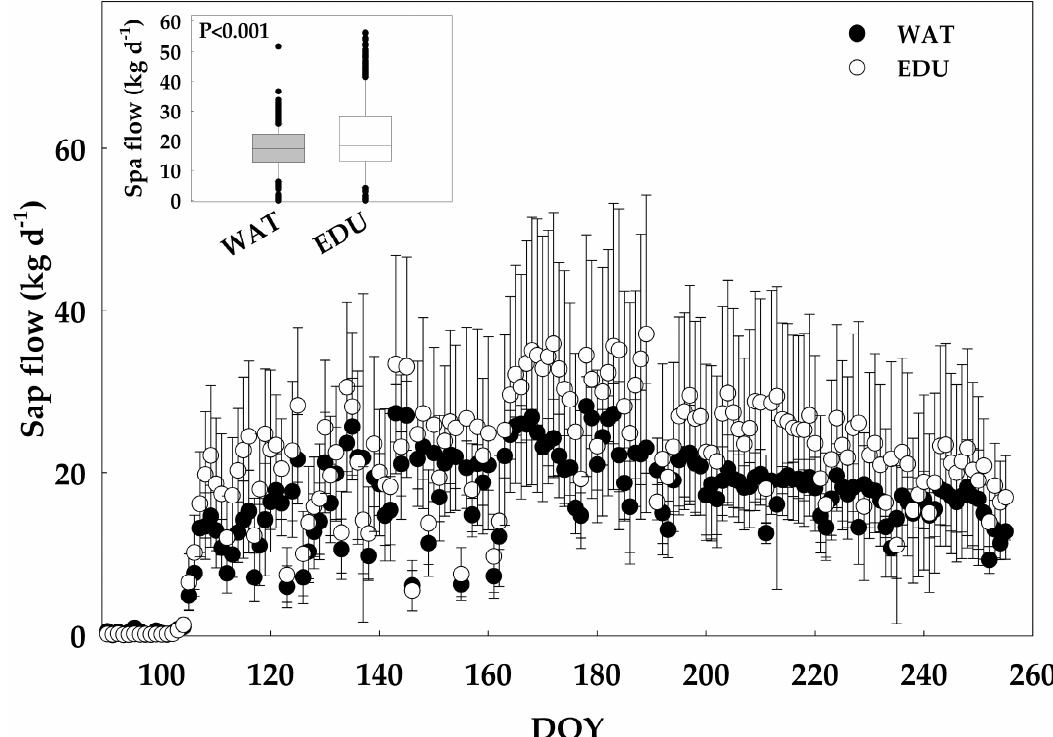
Figure 4. Time course of sap flow (±SD) during the growing season 2013 ( N = 5 trees). The inset shows the box-plot representing the range of daily sap flow in WAT (water treated) and O 3 -protected EDU (EDU treated) trees. The box shows the distribution of the 25–75% quartiles, the median is represented by a horizontal line within the box, vertical bars indicate minimum/maximum values and circles symbolize outlying data points. p -value was based on the Mann-Whitney test.